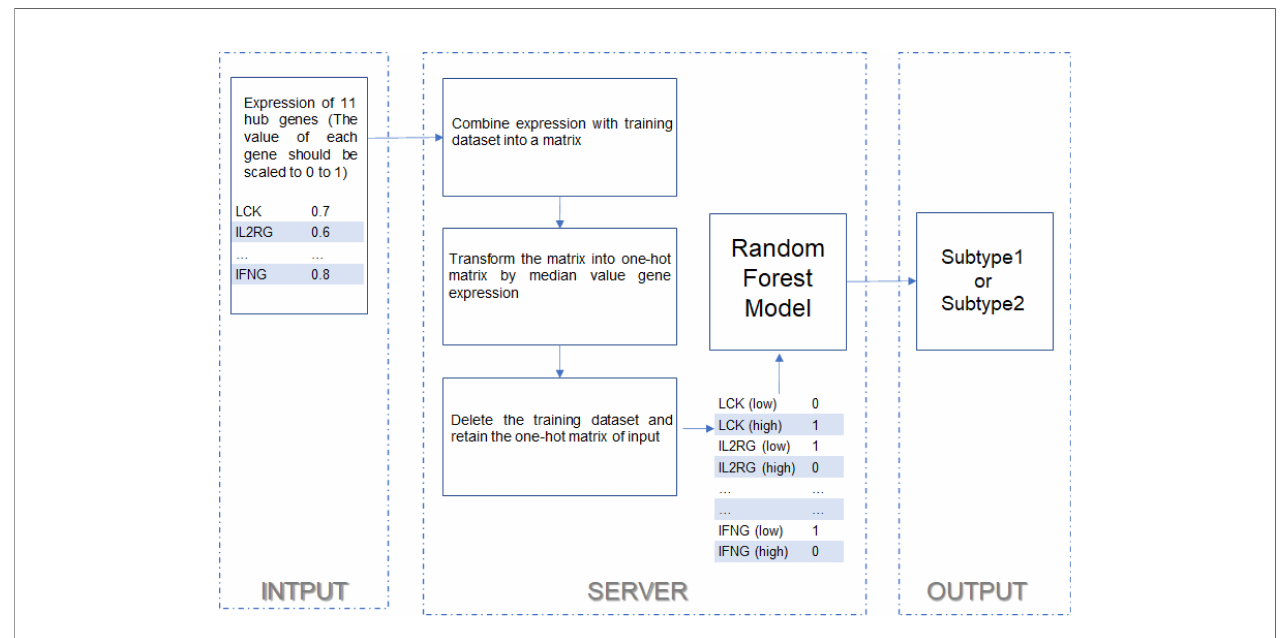
FIGURE 9 | The fl owchart of the shiny